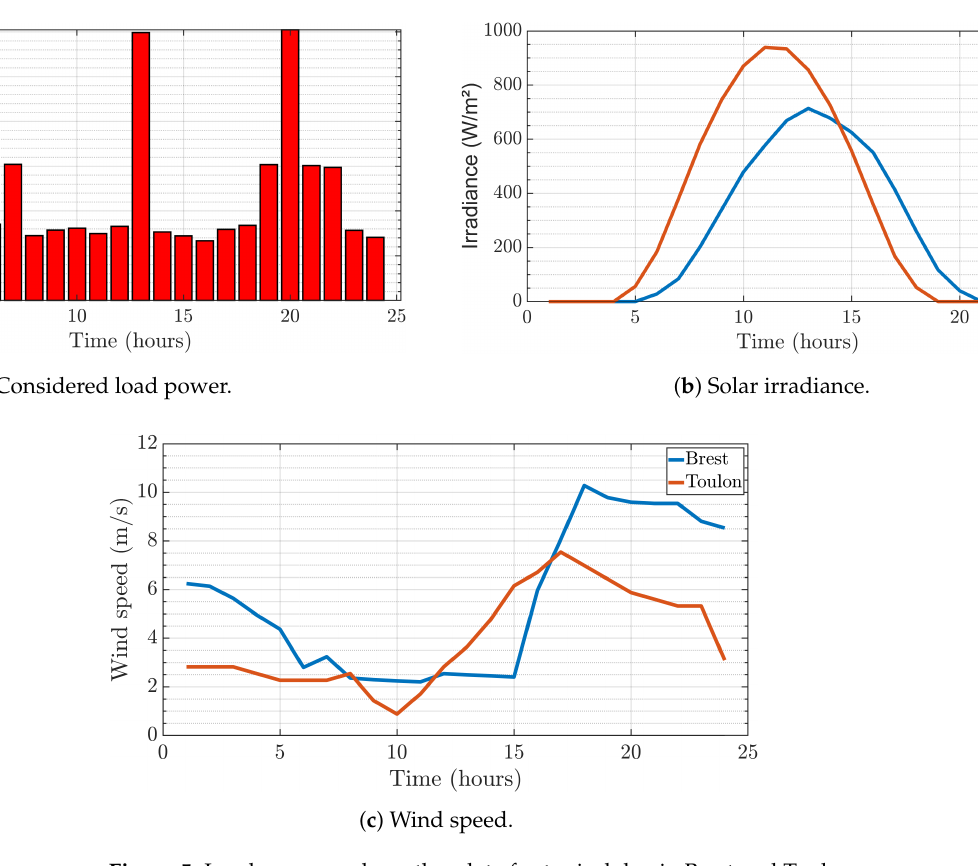
Figure 5. Load power and weather data for typical day in Brest and Toulon. Table 1. Investment, maintenance, and lifetime costs of the used energy resources, with a lifetime of 20 years for PV and wind turbine, and 5 years for batteries.